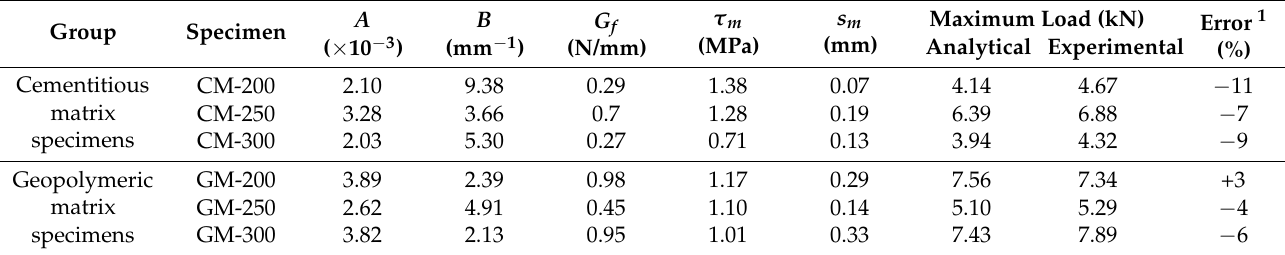
Table 3. Analytical results and comparison with measured maximum loads.